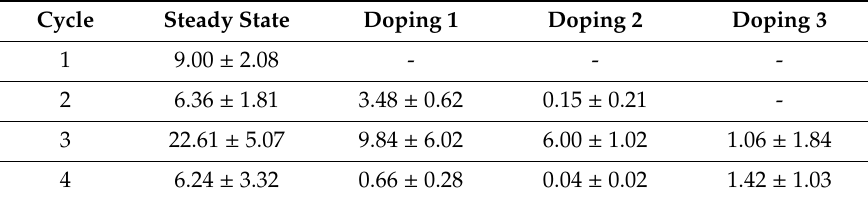
Table 6. N-NH 4 + removal rate